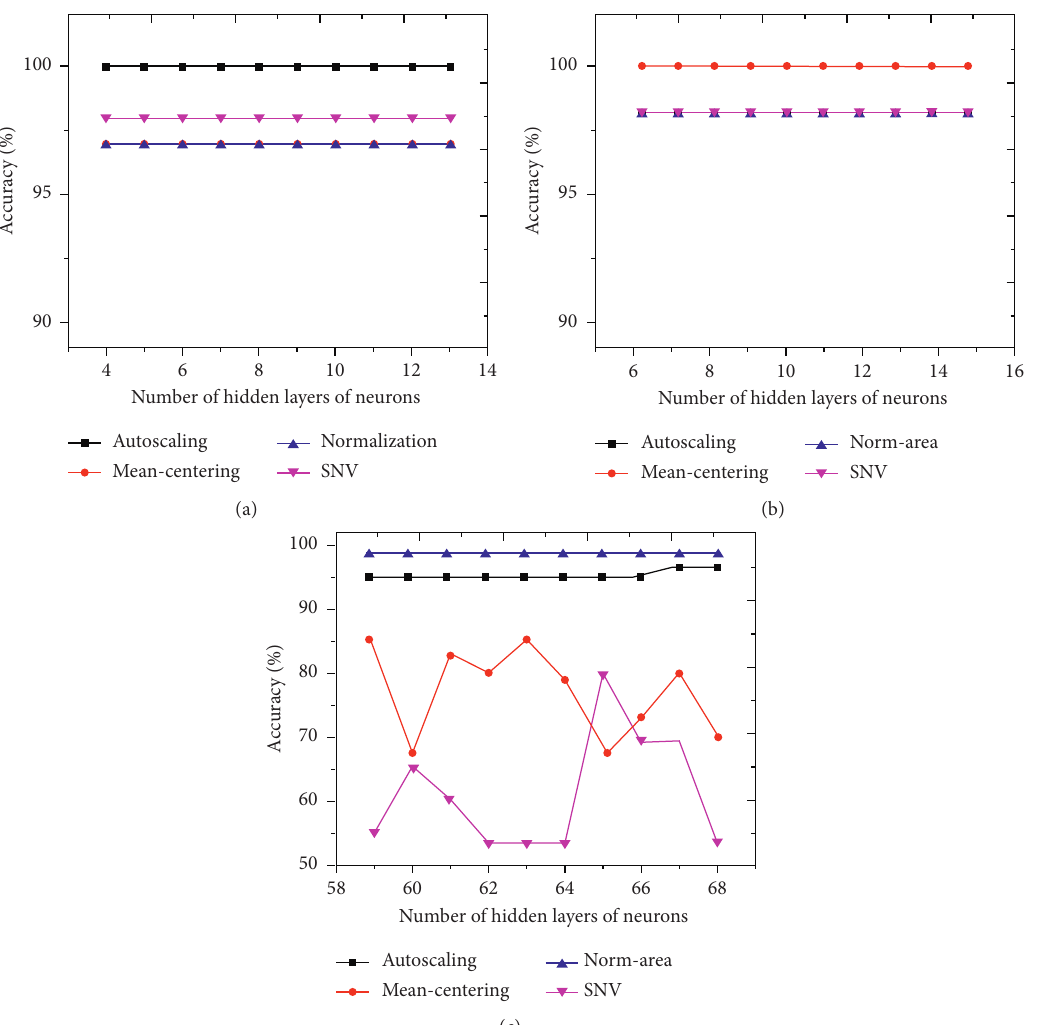
Figure 5: Accuracy results of ANN model generated by different types of input data: (a) the 10-line intensity, (b) 27-line intensity, and (c) all lines intensities, by using different preprocessing